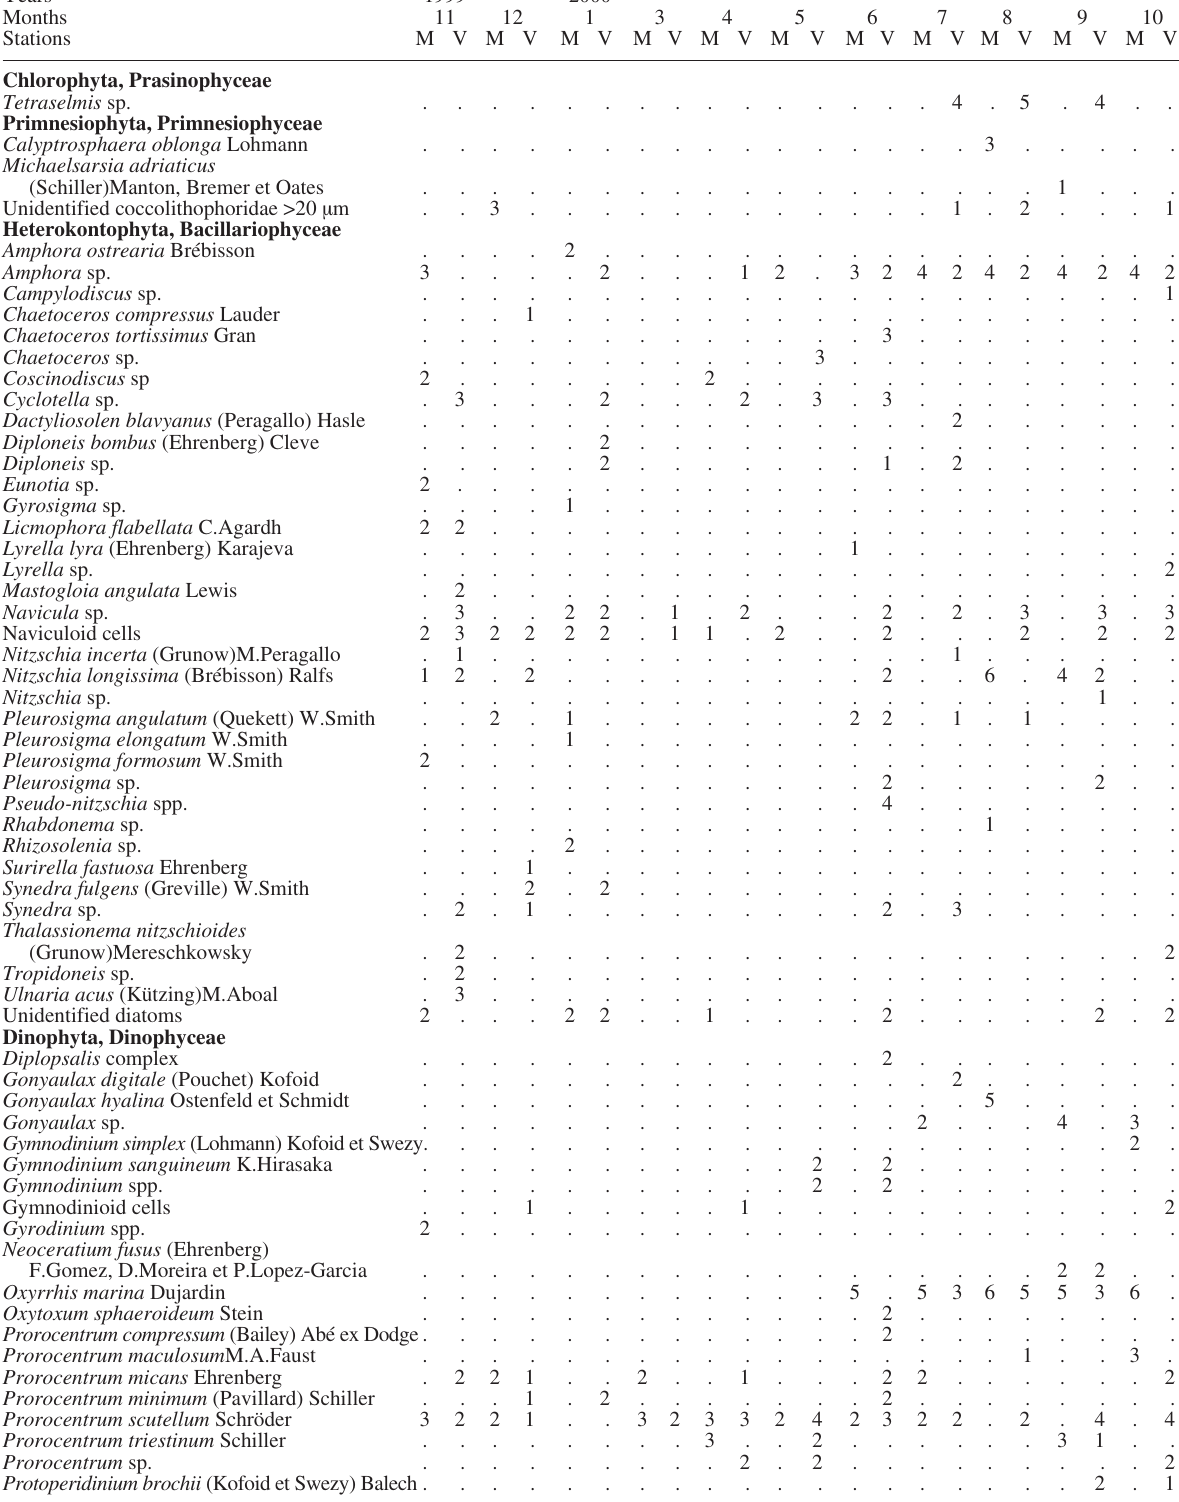
Table 1. – List of microphytoplankton taxa and monthly distribution of their abundance in Mala Solina (M) and Velika Solina (V) during the one-year investigation. Abundances are presented as follows: 1 = 10-10 2 ; 2 = 10 2 -10 3 ; 3 = 10 3 -10 4 ; 4 = 10 4 -10 5 ; 5 = 10 5 -10 6 ; 6 = 10 6 -10 7 cells L -1 .